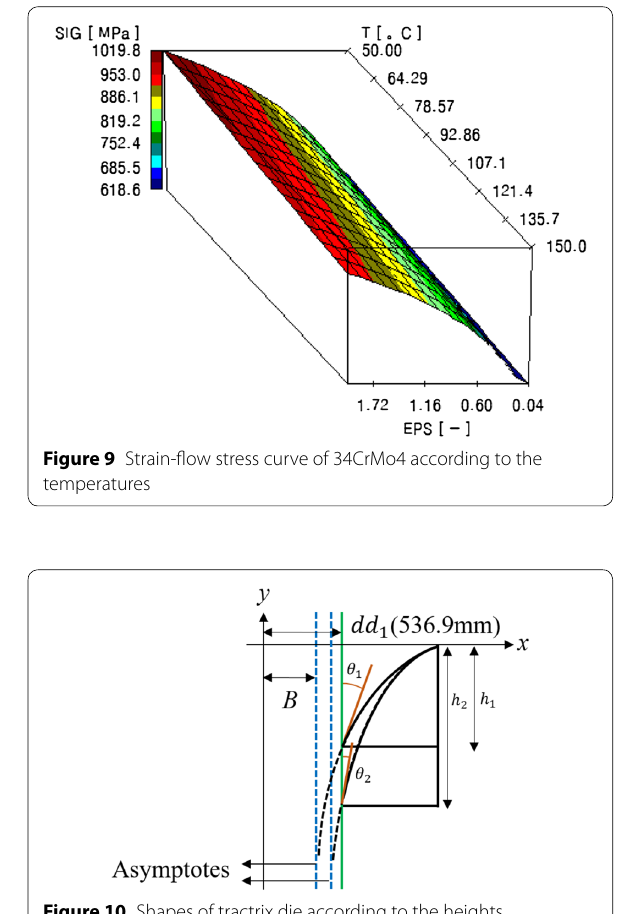
Figure 10 Shapes of tractrix die according to the heights